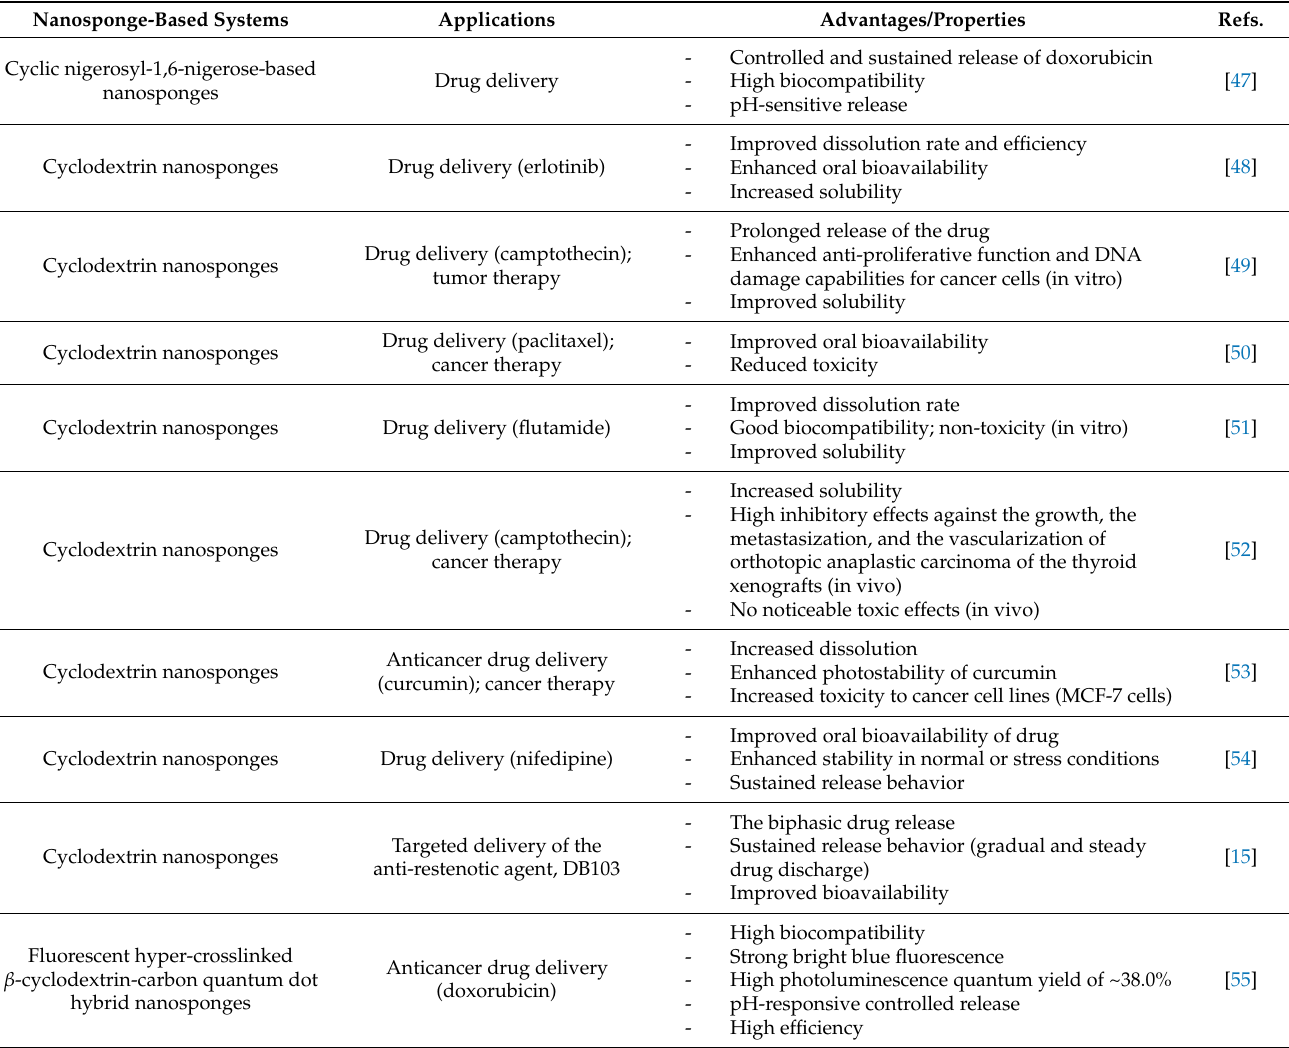
Table 1. Some selected examples of nanosponges in biomedicine with attractive benefits. Applications Advantages/Properties